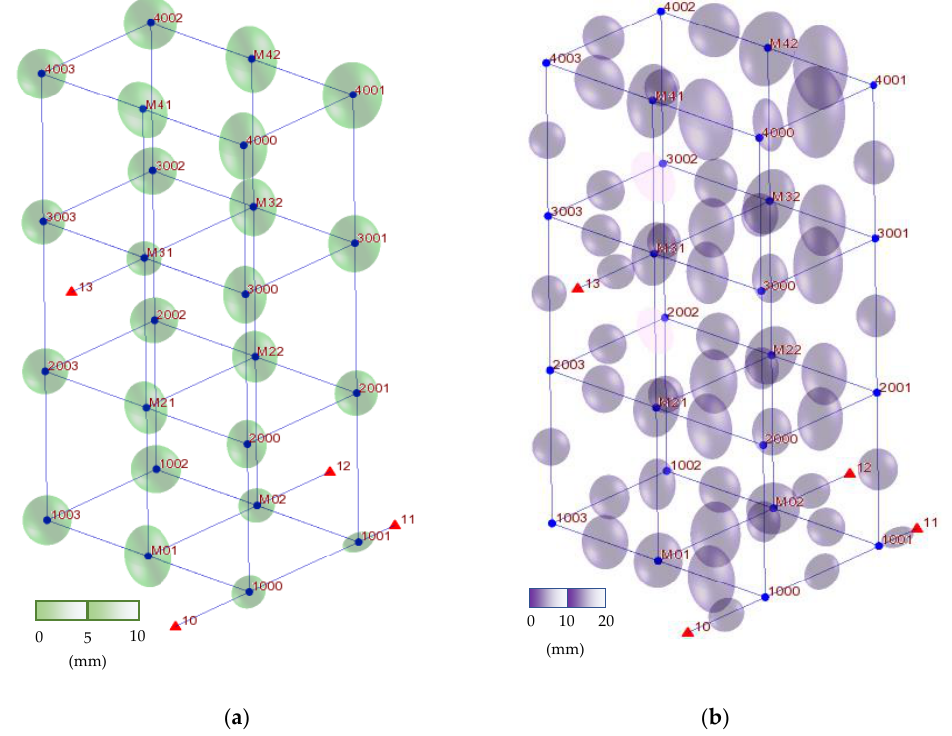
Figure 25. The error ellipses of coordinate determination for relative observations: ( a ) the accuracy ellipses of the point coordinate determination; ( b ) the relative accuracy ellipses of the point coordinates.